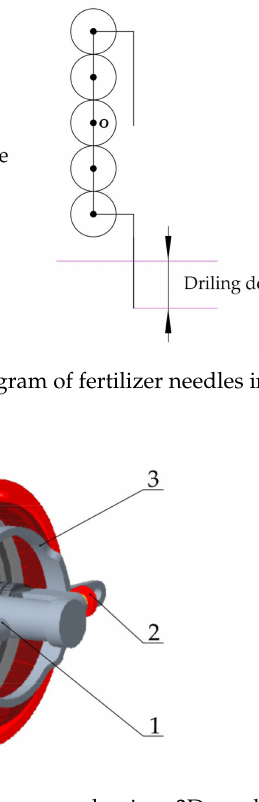
Figure 9. Cylindrical hollow cam mechanism 3D model.1. Roller; 2. Top bar; 3. Cylindrical hollow cam.